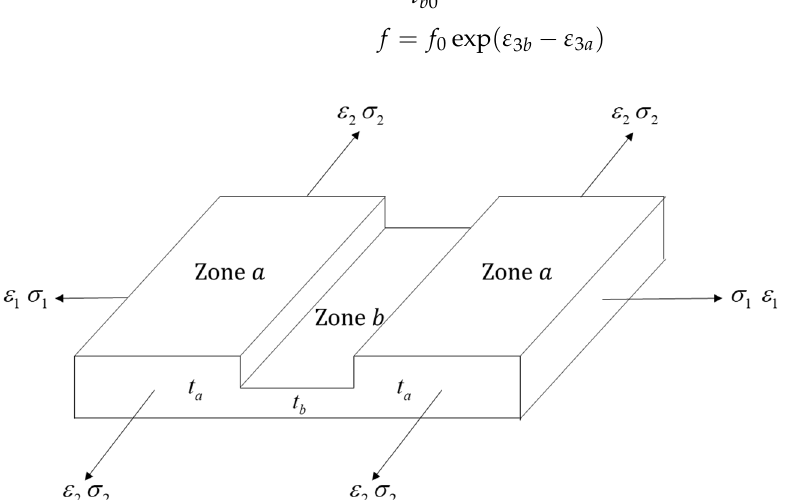
Figure 4. Schematic diagram of Zone a and b in the M-K model.